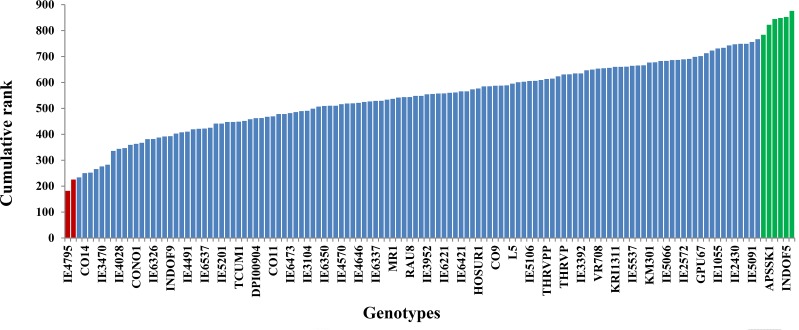
Cumulative ranks for all the traits for 128 genotypes of finger millet.The data were collected after 45 and 90 days of sowing the seeds for leaf blast and agronomic traits respectively. Superior and inferior genotypes are represented by green bars and red bars respectively.